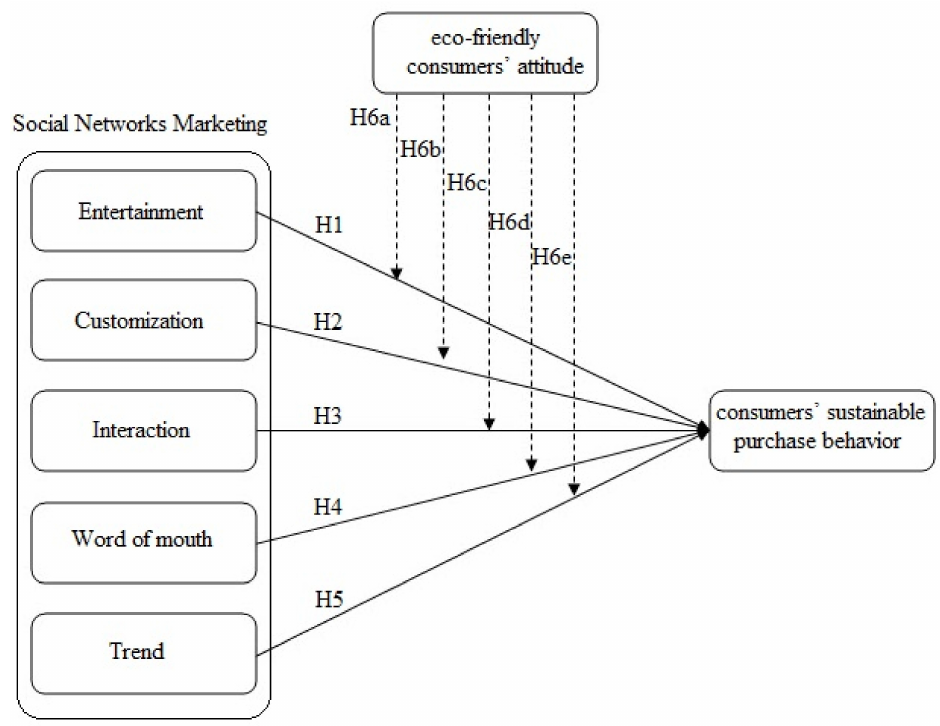
Figure 1. Research Model (Source: